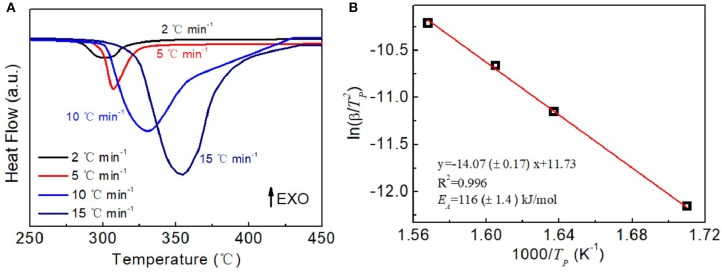
DSC (A) and the fitting Kissinger plots (B) of the MgH2-5 wt% CoNC0 at 2°C min−1, 5°C min−1, 10°C min−1, and 15°C min−1 heating rate.